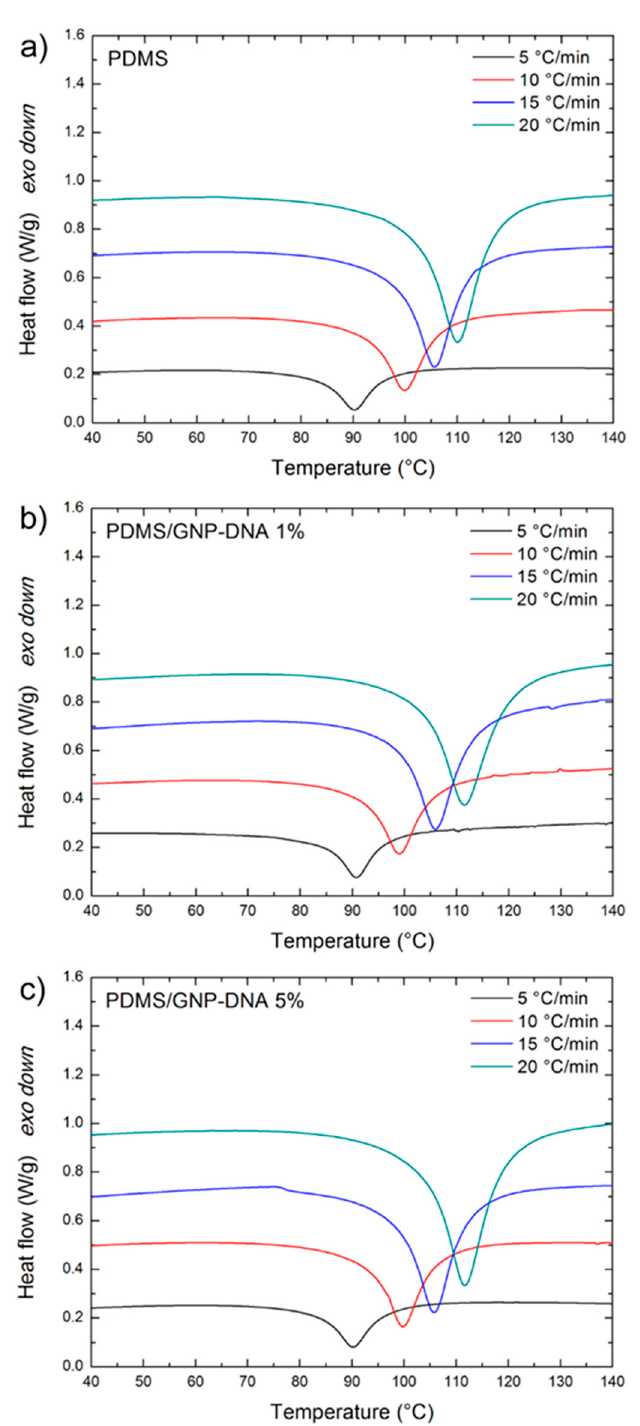
Figure 2. Differential scanning calorimetry (DSC) thermograms of ( a ) polydimethylsiloxane (PDMS) (Sylgard 184), ( b ) PDMS / GNP–DNA 1 wt% and ( c ) PDMS / GNP–DNA 5 wt% nanocomposite mixtures at different heating rates.